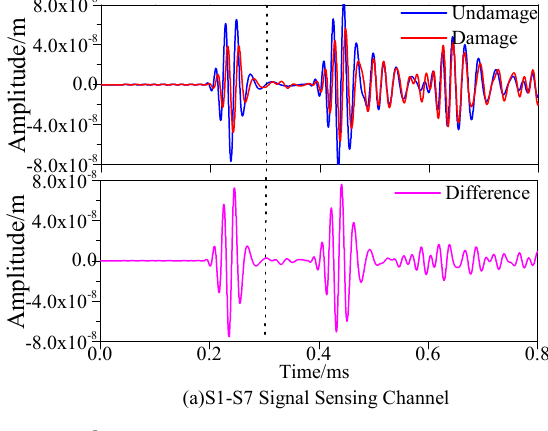
Figure 5. Response signals with different sensing channels. ( a )S1–S7 Signal Sensing Channel ( b )S5–S9 Signal Sensing Channel.